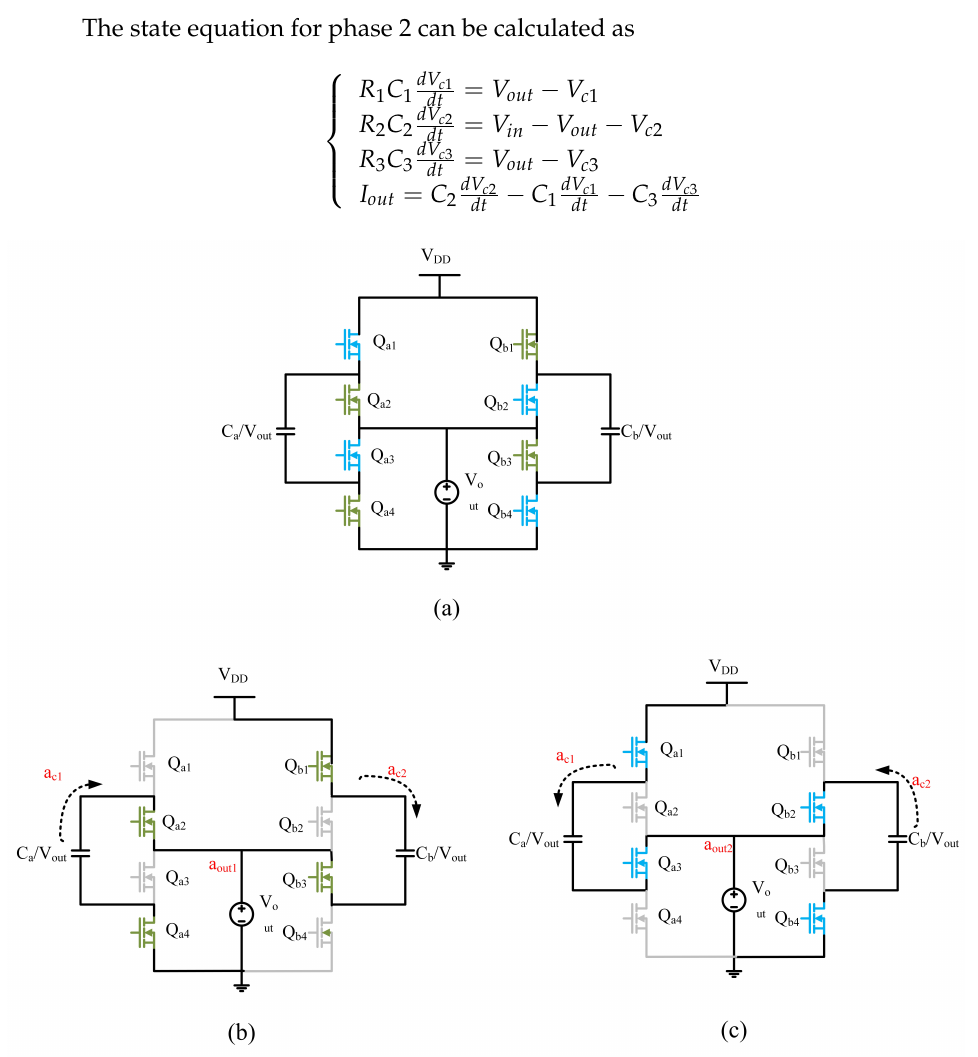
Figure 2. ( a ) Interleaved Doubler SCC topology. ( b ) Phase 1, ( c ) Phase 2. Supposing V in = 48 V, I out = 10 A, we can analyze the effect of capacitor value and ESR difference on charge flow condition. Switching frequency, capacitance, and ESR all influence the charge flow condition. Specifically, the resistance and charge transfer ratio on the branch are approximately inversely proportional, while the capacitance and charge transfer ratio are approximately proportional, as shown in Figure 4. It is obvious that the charge is not distributed equally in the two subcircuits when they are asymmetrical. As is apparent from the foregoing discussion, the traditional performance evaluation method based on output impedance cannot be applied to ill-posed